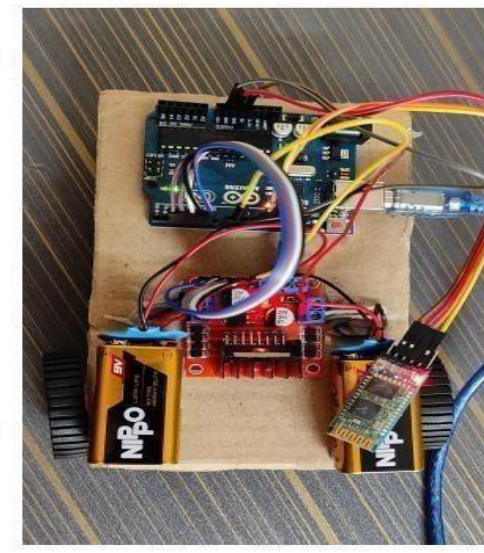
Fig. 6 Proposed model of Voice Controlled